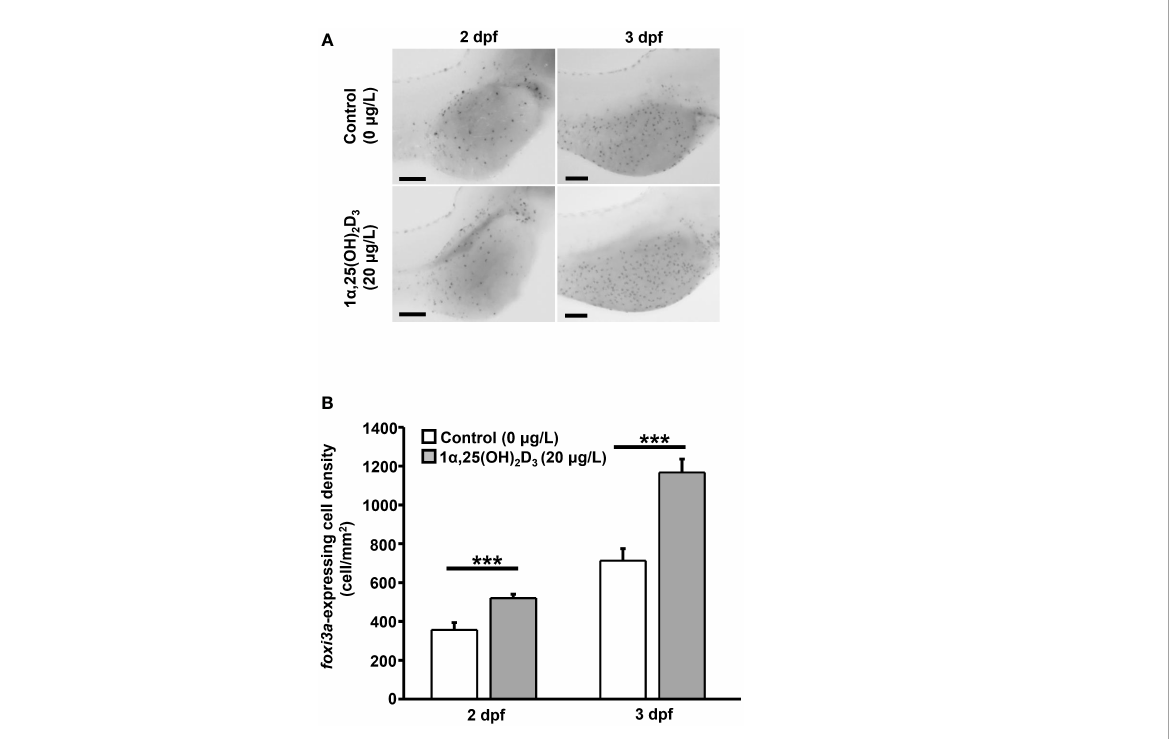
FIGURE 5 Effects of exogenous 1 a ,25(OH) 2 D 3 treatment on the density of foxi3a -expressing cell at the embryonic skin of 2 and 3 dpf zebra fi sh larvae. (A) The representative images of whole mount in situ hybridization showing the expression of foxi3a -expressing cell (black dots) in the yolk sac of zebra fi sh larvae treated with 0 (control) and 20 m g/L 1 a ,25(OH) 2 D 3 . (B) The quantitative data for the cell density. Values are mean ± SEM ( n = 9). Student ’ s t-test, *** p <0.001. Scale bar: 100 m